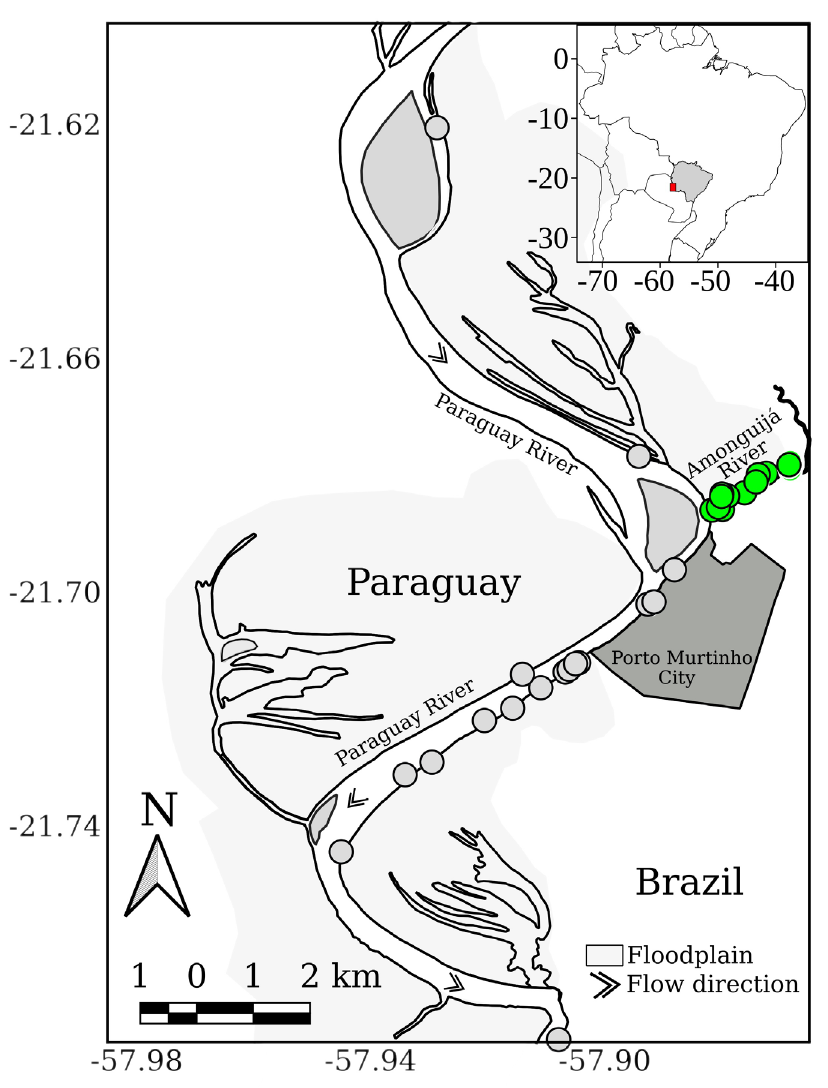
Figure 1. Location of sampling points along the Amonguijá (green circles) and Paraguay (gray circles) Rivers in the southern Pantanal, Porto Murtinho, MS,